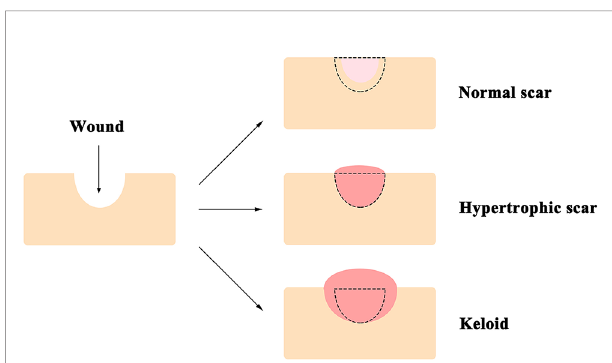
FIGURE 1 | A diagram of typical appearances of normal scar, hypertrophic scar, and keloid. Unlike that the normal scar is often smaller than the original wound, keloids extend beyond the edge of the original wound, while hypertrophic scars are restricted to the wound borders. The black dotted line demarcates the area of the original